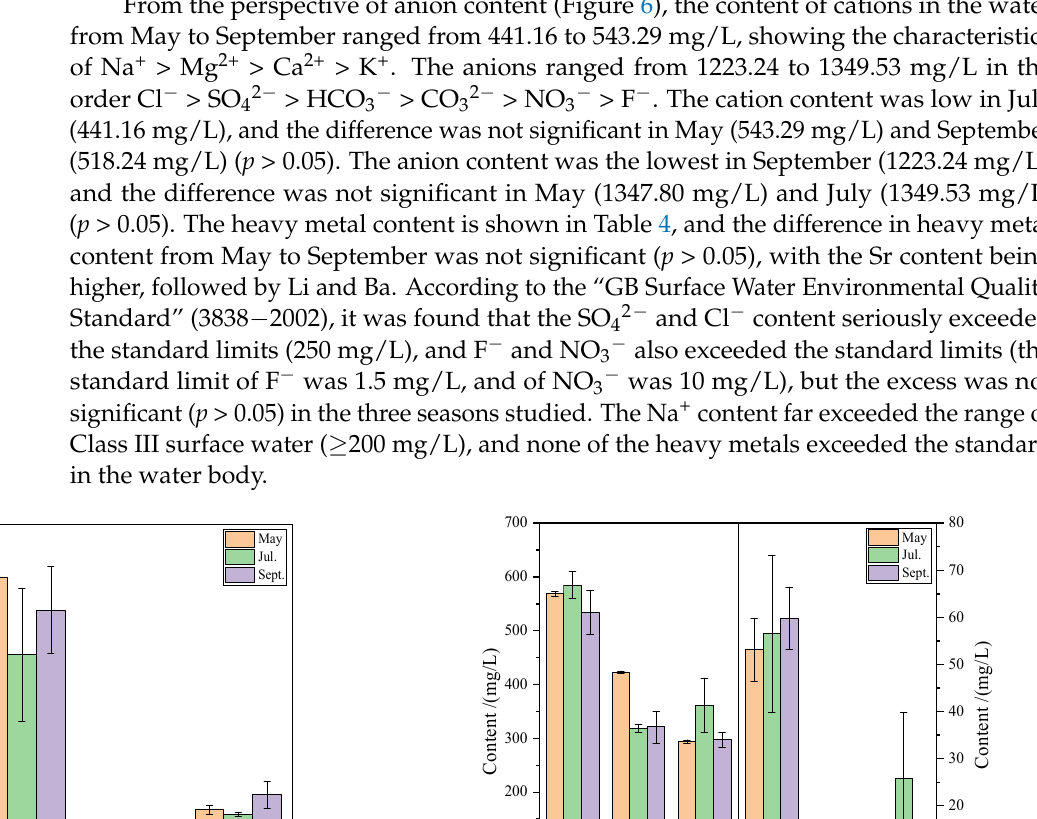
Figure 5. Physical and chemical indicators of water quality at different sampling sites (±S.E). Notes: ( a ): SD. ( b ): pH. ( c ): BOD 5 . ( d ): Chl − a. ( e ): COD. ( f ): DO. ( g ): EC. ( h ): NH 3 − N. ( i ): TDS. ( j ): WT. ( k ): TP.